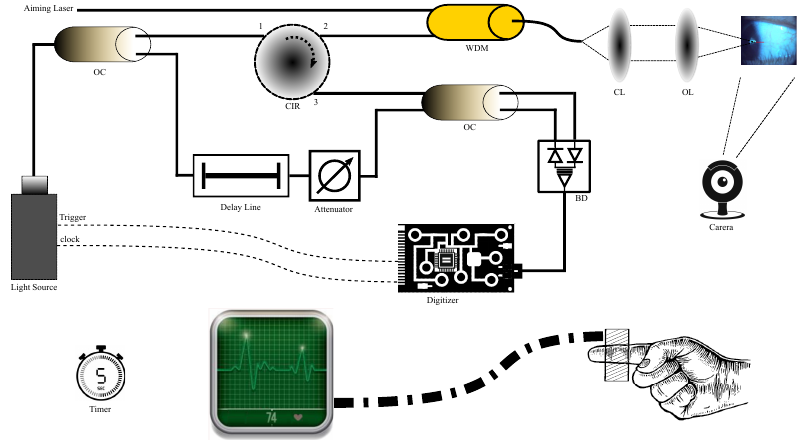
Figure 2. Schematic of the measurement system used in this study, which includes an SS − OCT, a camera for orienting the scan target and a blood pressure gauge with the finger attached. The detector of the SS − OCT and the BPG device was triggered to record simultaneously. WMD: wavelength division multiplexer; OC: optical coupler; CIR: circulator; CL: collimating lens; BD: balanced detector; OL: objective lens.